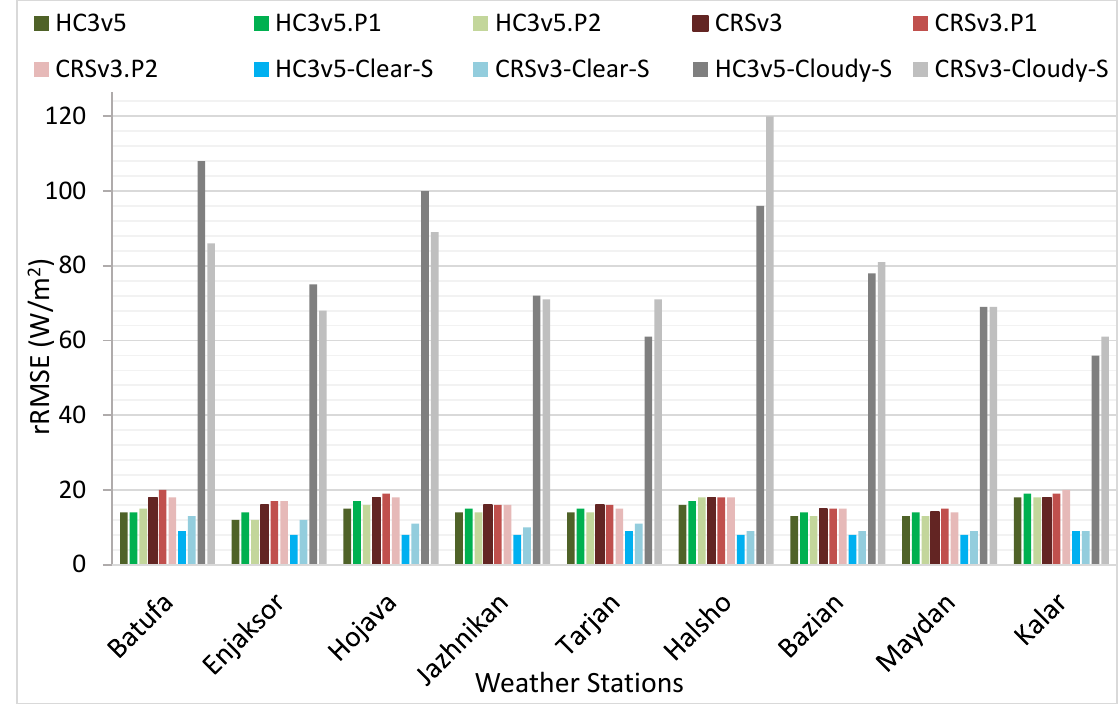
Figure 7. Comparison of rBias for the hourly GHI for all-sky conditions among stations with points around them for HC3v5 and CRSv3. Clear-skies and cloudy-skies at stations are represented by blue, light blue, black and grey colours, respectively.